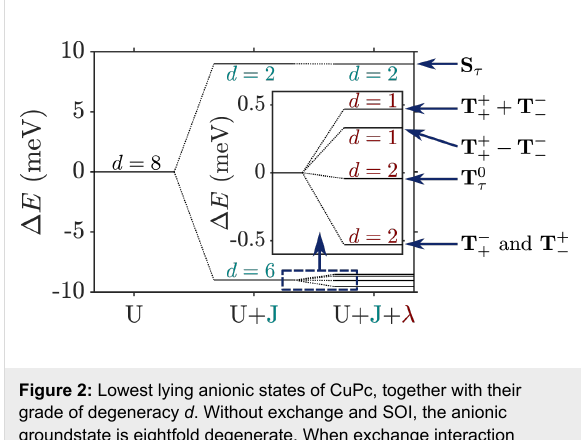
Figure 2: Lowest lying anionic states of CuPc, together with their grade of degeneracy d . Without exchange and SOI, the anionic groundstate is eightfold degenerate. When exchange interaction between SOMO and LUMOs is introduced, the degeneracy is lifted, yielding two triplets and two singlets because of the orbital degen- eracy of the LUMO. SOI further splits the triplet states, generating a twofold degenerate anionic groundstate consisting of the states and .